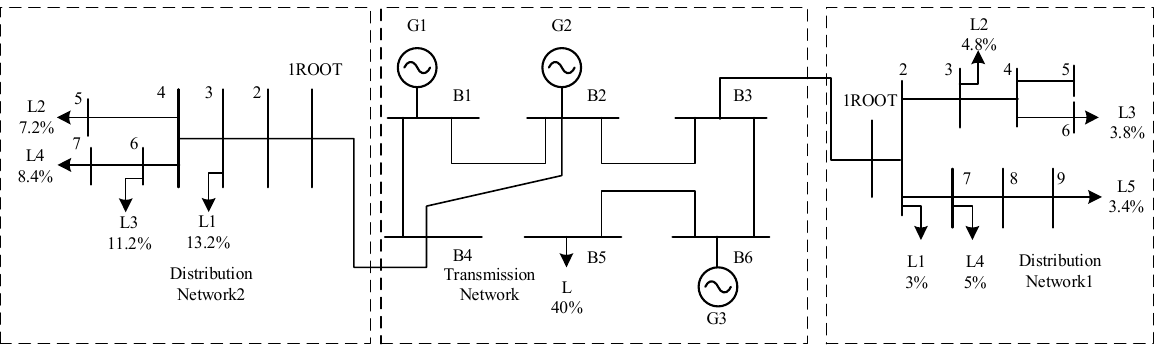
Figure 2. Example structure diagram.